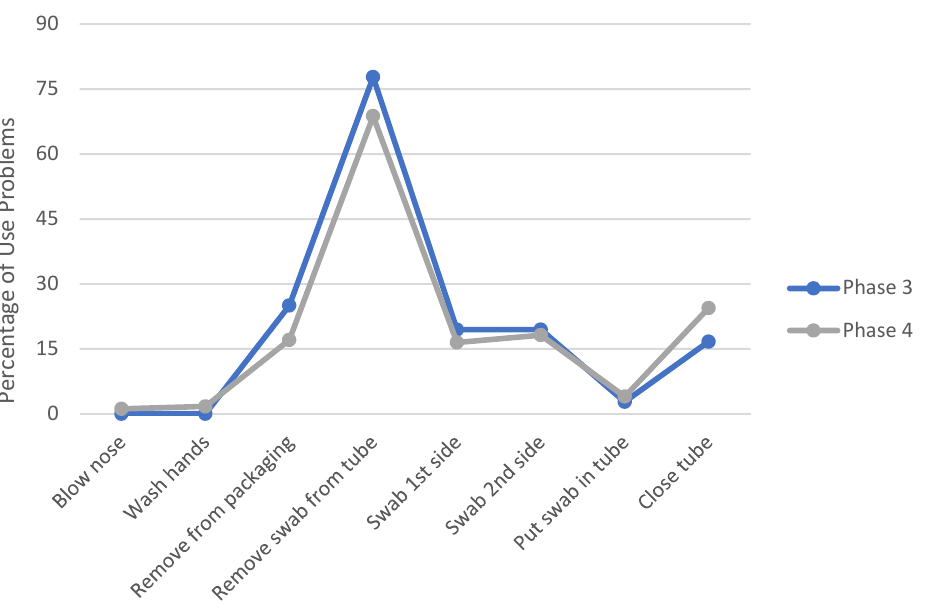
Figure 10. Percentage of students experiencing use problems per task across Phases 3 and 4 using XpressCollect.